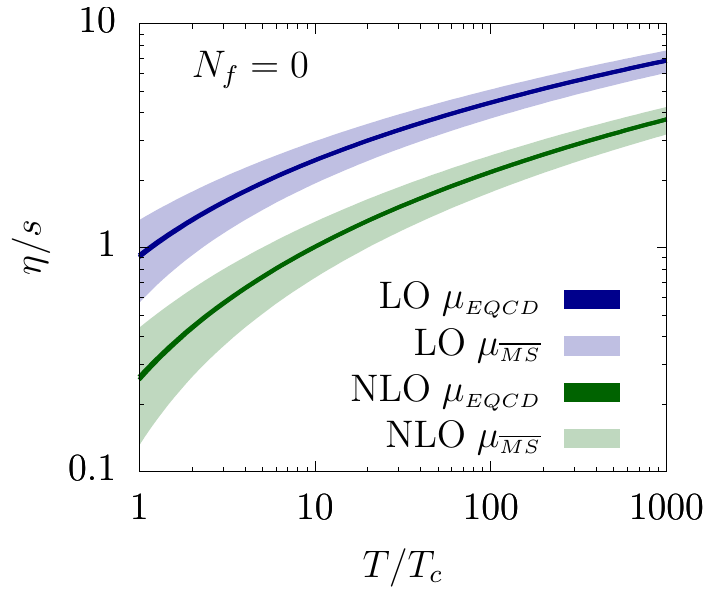
Figure 11 . The (cid:17)=s ratio as a function of the temperature for N c = 3, N f = 0 pure Yang-Mills theory. The thin darker bands and the thicker lighter bands respectively show the EQCD and MS renormalization schemes with (cid:22) = ( (cid:25) 4 (cid:25) ) T . $ In (cid:12)gure 11 we plot the (cid:17)=s ratio in N = 3 Yang-Mills theory as a function of c